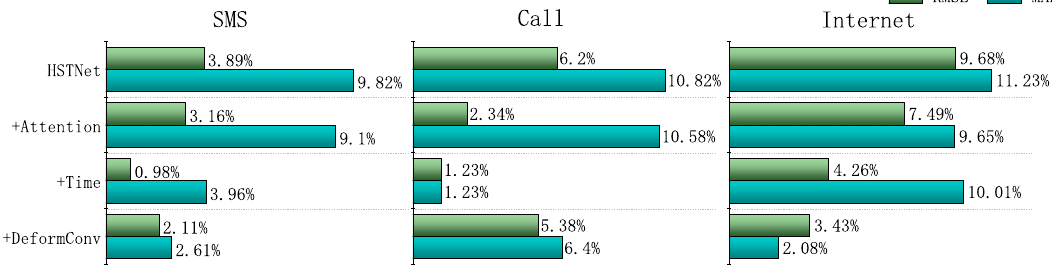
Figure 9. Comparison of different module effects based on STDenseNet.